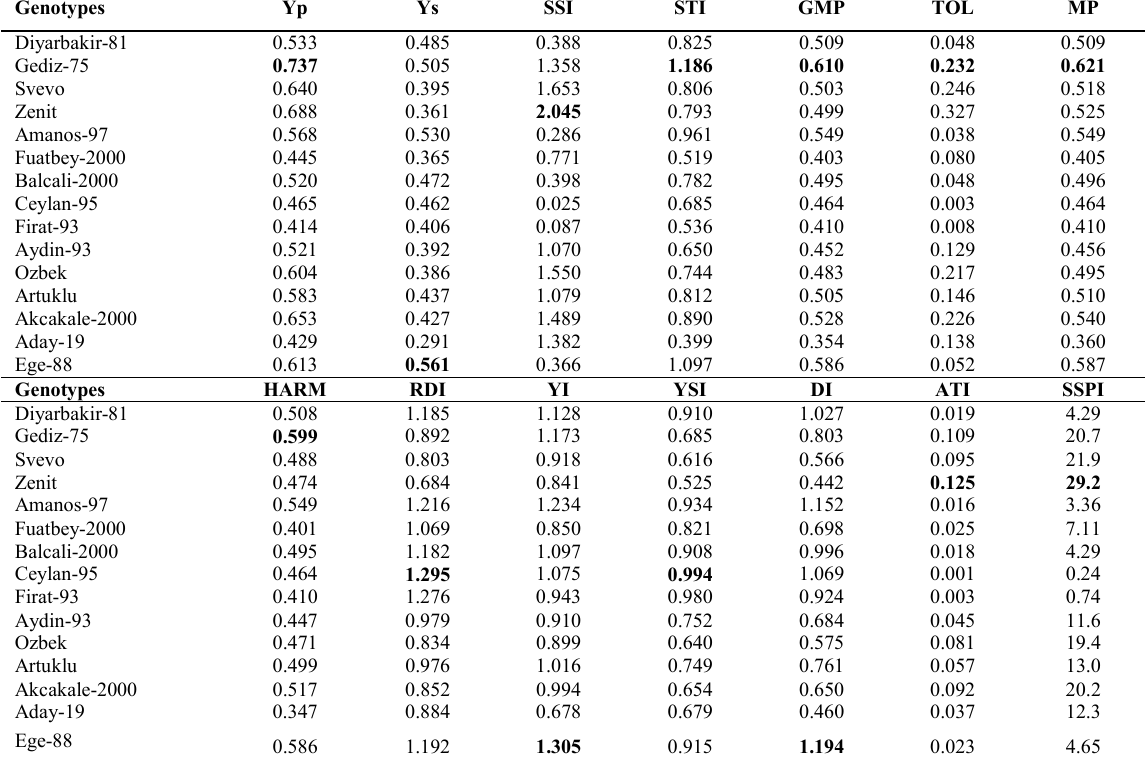
Table 6. The amounts of yields in normal and zinc deficient conditions and zinc resistance indices in studied durum wheat